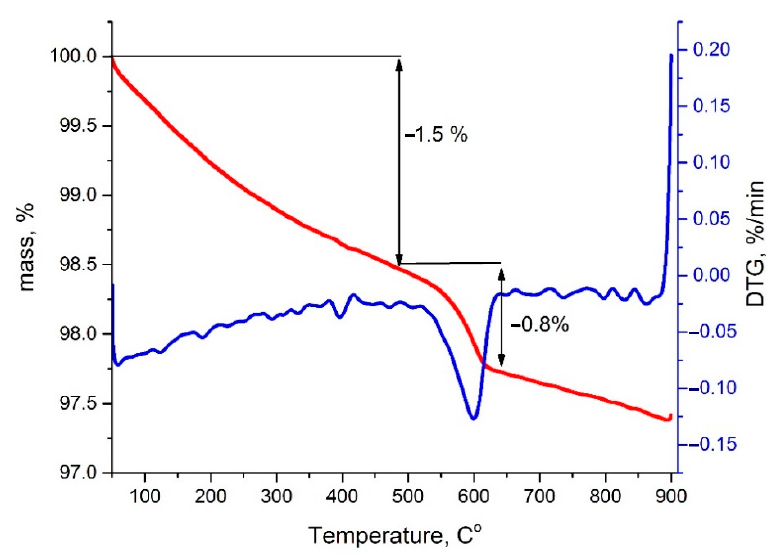
Figure 3. HRTEM images of the sample before and after the reaction.